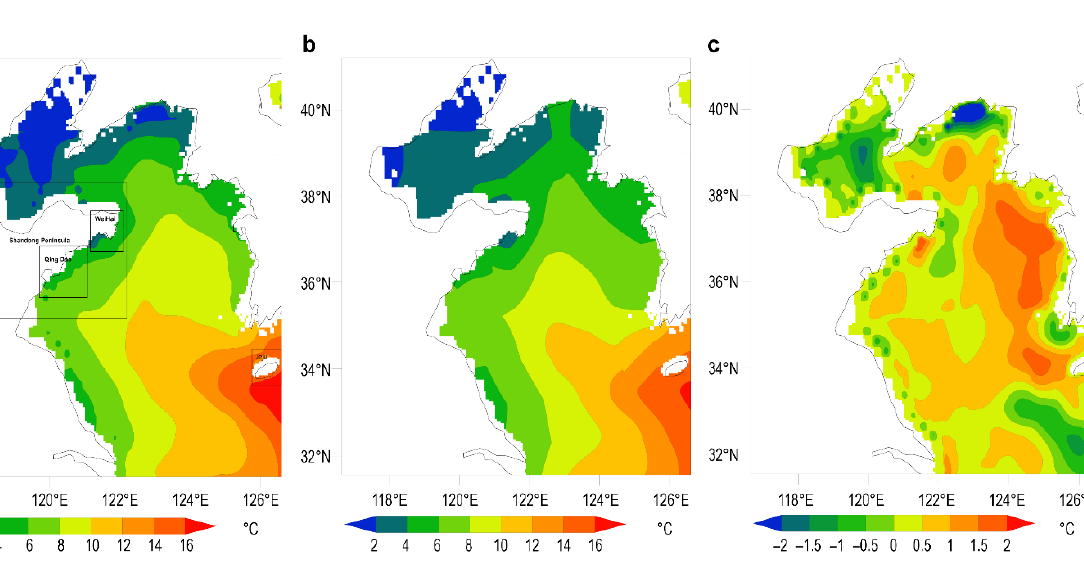
Figure 6. Daily SST distribution and temperature difference between FNL and CODAS at 00:00 UTC on 18 February 2020. ( a ) CODAS SST, ( b ) FNL SST, and ( c ) temperature difference between CODAS SST and FNL SST.